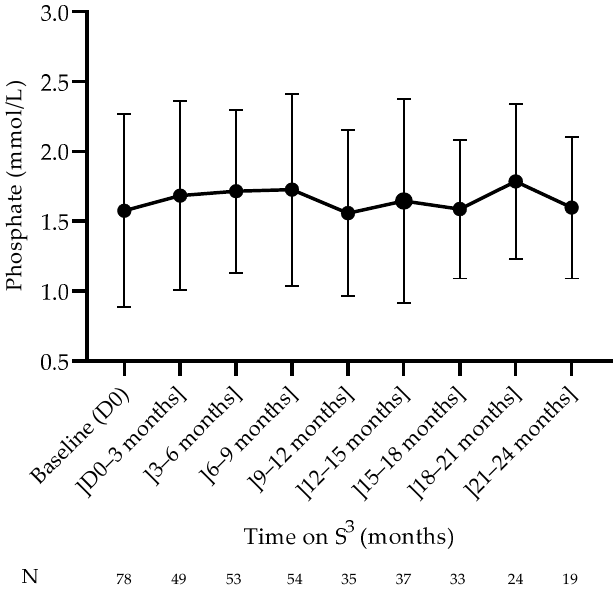
Figure 4. Evolution of plasma phosphate concentrations (median ± IQR).